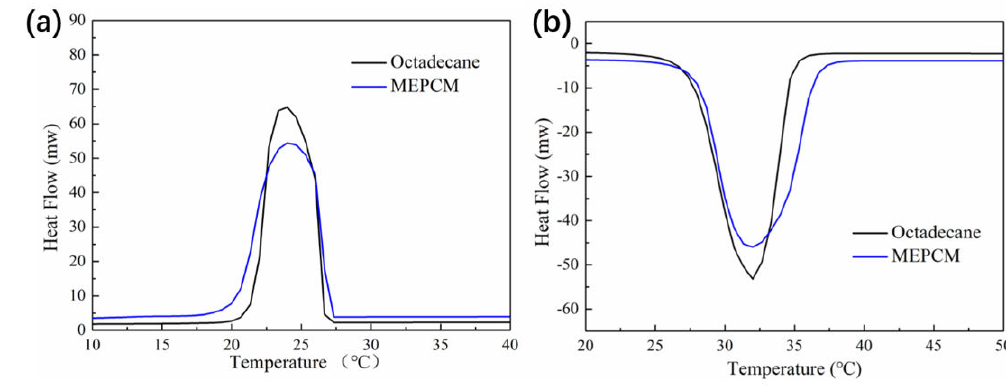
Figure 4. DSC curves of the MEPCMs and octadecane: ( a ) solidifying and ( b ) melting.